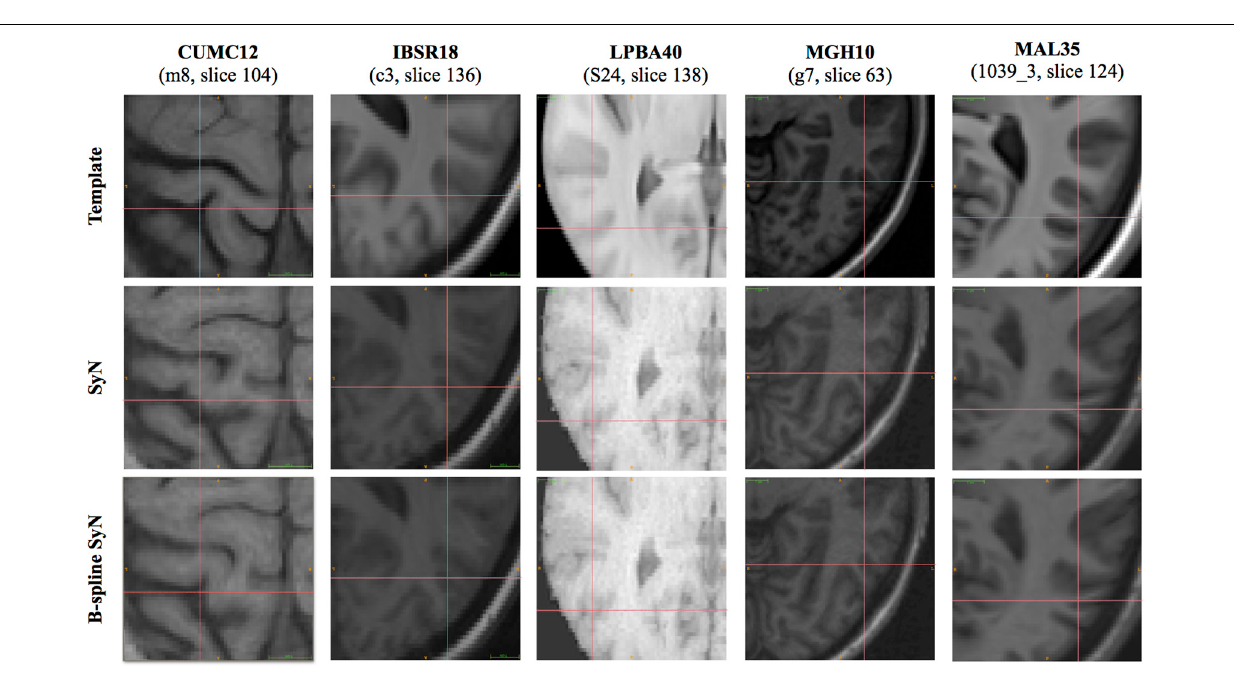
FIGURE 7 | Randomly selected axial slices showing qualitative differences between SyN and B-spline SyN. Crosshairs indicate regions of maximal Jacobian